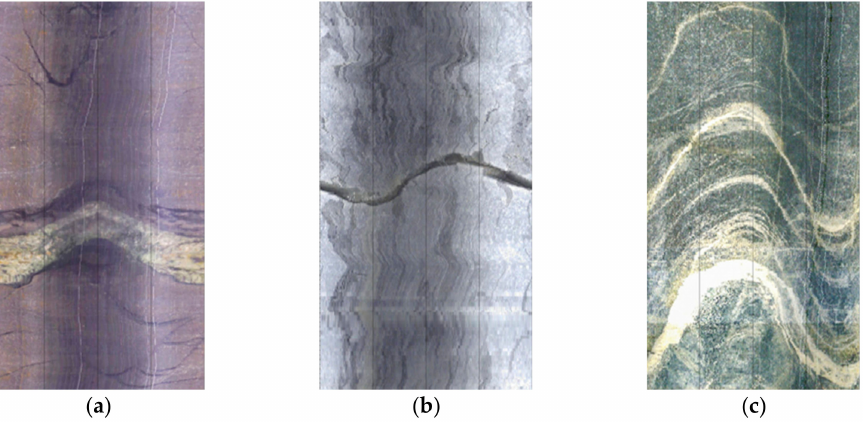
Figure 5. Some common structural plane characteristics. ( a ) Rock veins filling. ( b ) Opening crack. ( c ) Texture